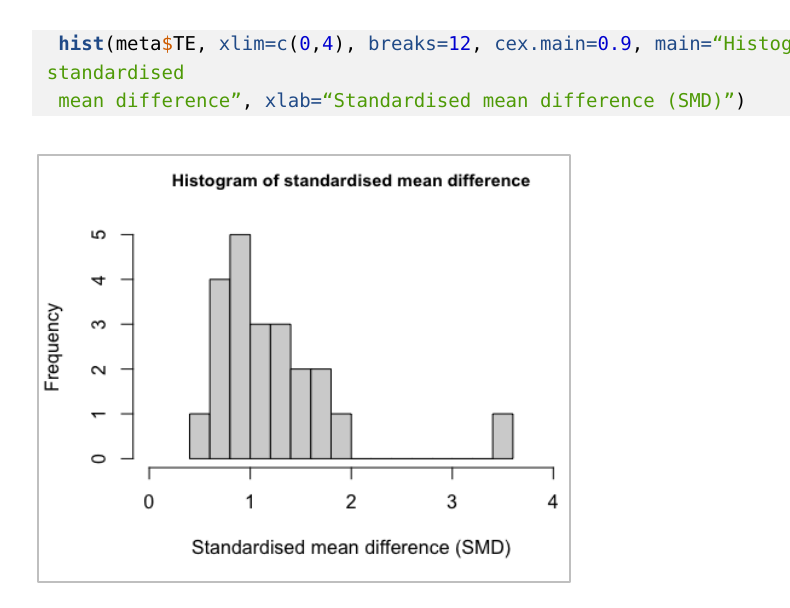
Figure A1. The distribution of the SMD of stable MCI (MCI_St) versus MCI_AD is slightly skewed and shows an outlier, but is otherwise approximately normal.